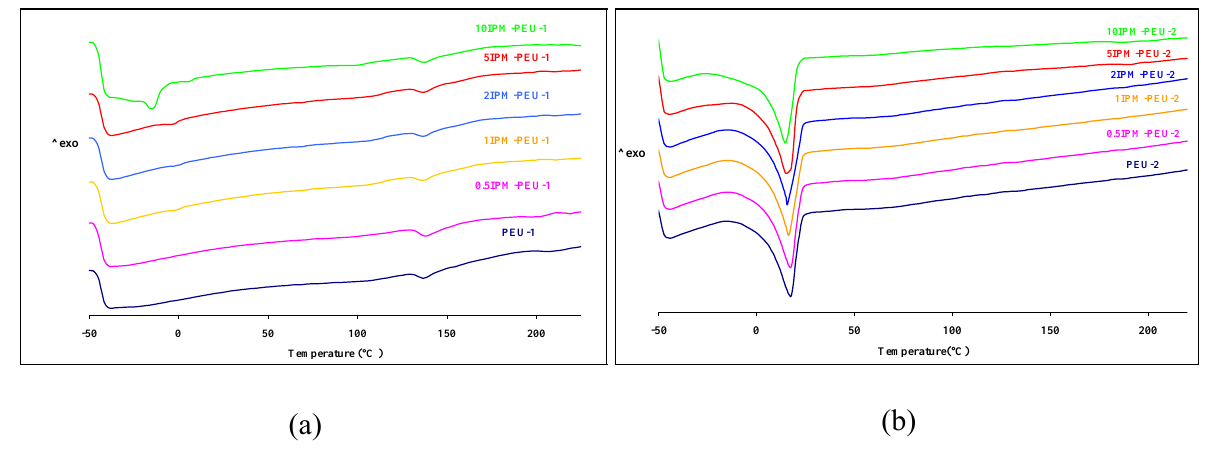
Figure 4. DSC thermogram of (a) IPM-PEU-1 series (b) IPM-PEU-2 series